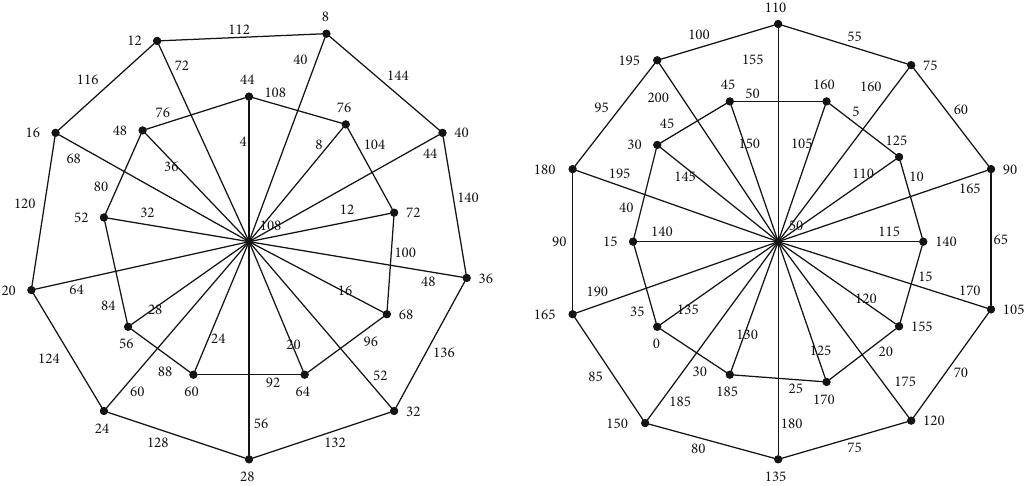
Figure 6: The graphs W